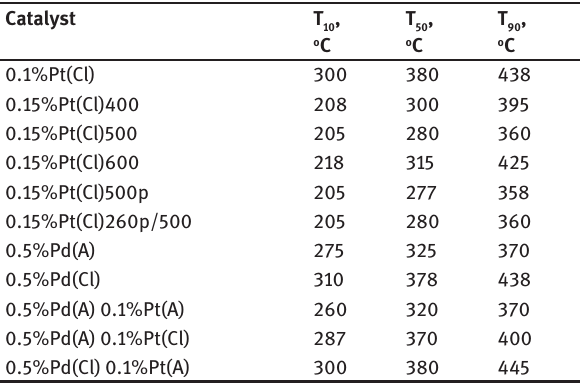
Table 2: Comparison of temperatures of 10% (T (T ) hexane conversion over different monolithic 90